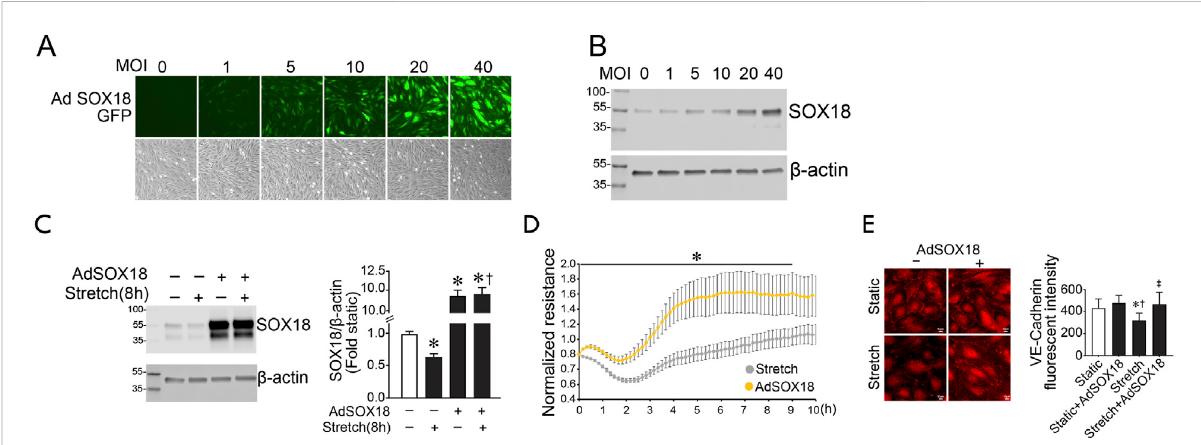
FIGURE 2 SOX18 overexpression prevents the loss of barrier function in human lung microvascular endothelial cells exposed to cyclic stretch. SOX18 overexpression was induced with an adenovirus (AdSOX18) containing SOX18 and GFP as a reporter (each with its own promoter). HLMVECs were treated with AdSOX18 for 48 h with an MOI of 40 unless otherwise indicated. HLMVEC lysates were analyzed by immunoblot using SOX18 antibody. HLMVECs were analyzed by immuno fl uorescent staining using VE-cadherin antibody after being subjected to 18% cyclic stretch for 8 h. Fluorescentmicroscopyshowsaproportionalincreaseinadenoviralexpressionasindicatedbytheincreaseingreenlight fl uorescencefromtheGFP reporter (A) . SOX18 overexpression was con fi rmed by immunoblotting (B) . Densitometric analysis shows a signi fi cant increase in SOX18 expression after treatment ofHLMVECswith AdSOX18 inbothstaticand subjectedtocyclicstretch cells relativeto thenon-adenovirus pretreated cells (C) .The transendothelial resistance reduction in HLMVECs subjected to cyclic stretch is ameliorated in cells overexpressing SOX18 (D) . Overexpression of SOX18 prevents VE-cadherin loss after cyclic stretch in HLMVECs (E) . * p < 0.05 versus Static (C,E) or AdSOX18 (D) , † p < 0.05 versus Stretch (C) or Static + AdSOX18 (E) , ‡ p < 0.05 versus Stretch. N = 14 – 20 (C) ; N = 4 (D) ; N = 21 – 31 (E) .